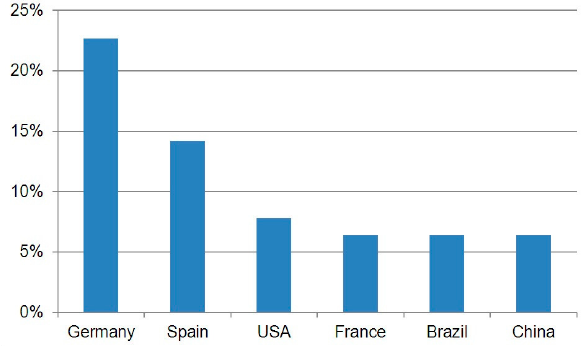
Figure 11. Distribution of surveyed publications between the top six countries.